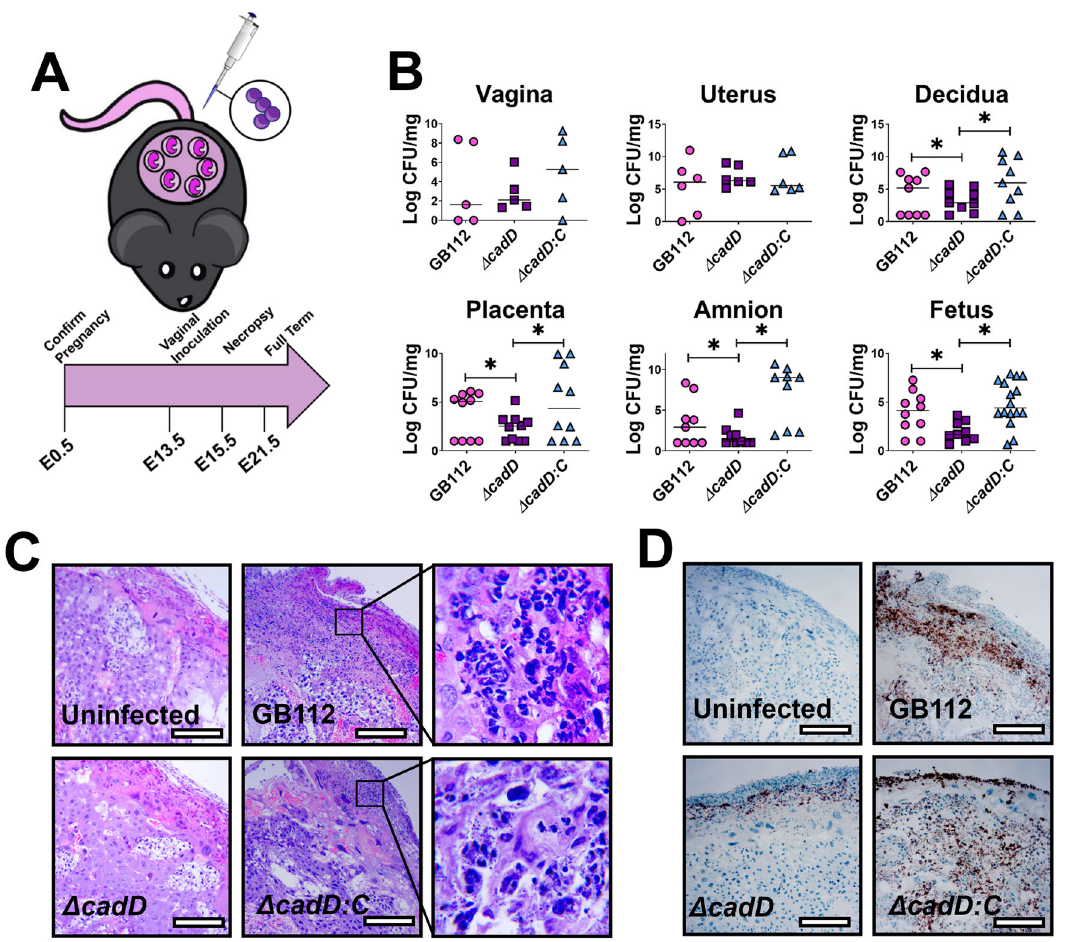
Fig. 5 | CadD plays a critical role in ascending GBS infection of a pregnant mouse. A Conceptualdiagramof methodsutilizedin these studies. Pregnant mice were infected with GBSon embryonicday 13.5and sacri fi ced 2dayspost-infection. Reproductive tissues were collected for analyses. B Bacterial burden within reproductive tissues was evaluated by quantitative culture to determine Log CFU/ mg (vaginal tissue was collected from 5 dams per experimental group, uterus tis- sueswerecollectedfrom6separatedams,andallothertissueswerecollectedfrom 6 separate fetal-placental units per experimental group). Signi fi cant changes in burden were observed between the WT GB112 and Δ cadD mutant in the decidua (* P =0.0257), placenta (* P =0.0003), amnion (* P =0.0312), and fetus (* P =0.0266) by one-tailed Mann – Whitney U analysis. These results were reversed by genetic complementation in trans resulting in signi fi cant changes in burden observed